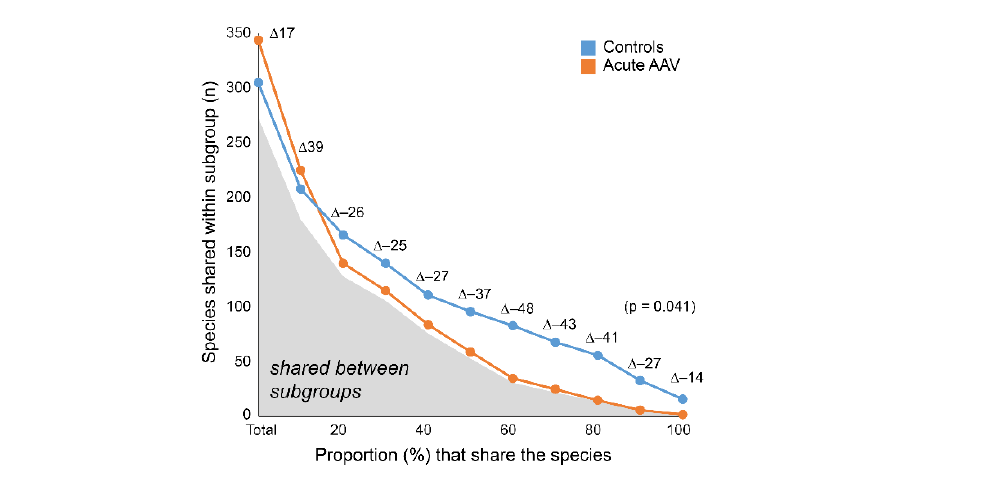
10 of 19 Figure 3. Diversity measures of saliva microbiota in acute AAV and control individuals. Violin plots illustrating beta-diversity based on ( a ) quantitative phylogeny measures by the Bray–Curtis dis- tance matrix ( q = 0.001) or ( b ) Weighted UniFrac distance matrix ( q = 0.018) or qualitative measures ( c ) without phylogeny by the Jaccard distance matrix ( q = 0.001) or ( d ) with phylogeny by the Un- weighted UniFrac distance matrix ( q = 0.006). Alpha-diversities for ( e ) richness and evenness (Shan- non index, q = 0.034), ( f ) evenness (Evenness index, q = 0.042), ( g ) the number of ASVs at different sequencing depths, ( h ) violin plots with box plots for the total number of ASVs at 20,000-read se- quencing depth, and ( i ) phylogenetically (Faith index, q = 0.942). To understand the nature of the beta-diversity in acute AAV samples, we evaluated the number of shared taxa (“core” microbiota) by sliding cut-off levels for the proportions of shared species. The analyses were done separately for the acute AAV and control